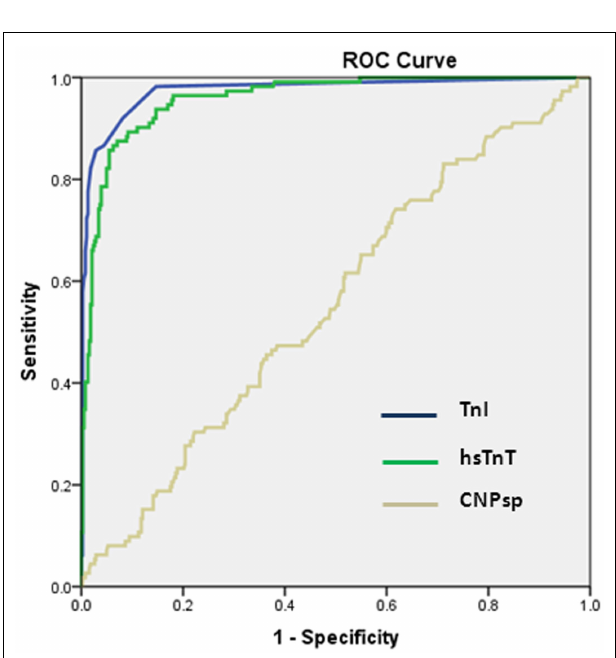
FIGURE 2 | Receiver operator curve curves for the identification of MI ( n = 112) in the chest pain study group . Clinical TnI and investigational hsTnT assays performed similarly (both P < 0.001). CNPsp measurement did not generate a significant AUC (0.56, P = 0.07) for the identification of MI and did not add to TnI or hsTnT